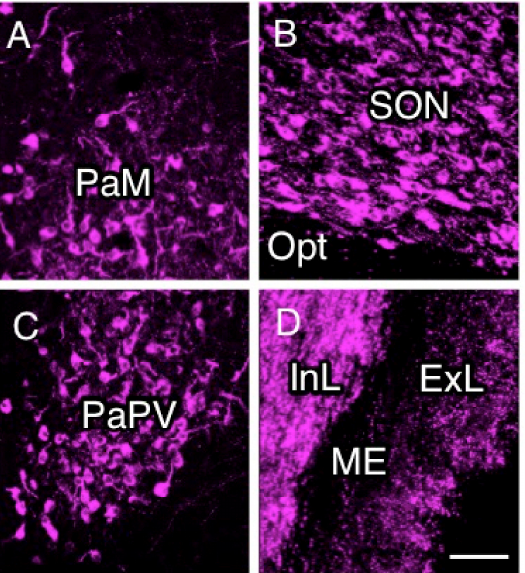
Figure 2. Immunofluorescence for vasopressin-associated neurophysin (NPII) in the macaque hy- pothalamus. NPII-immunoreactivity was observed in the paraventricular nucleus (PVN) of the hypothalamus; PaM, magnocellular part of the PVN ( A ); supraoptic nucleus ( B ); PaPV, parvocellular part of the PVN, ventral division ( C ); and median eminence (ME) ( D ). Opt, optic nerve; InL, internal layer of the ME; ExL, external layer of the ME. Scale bar, 100 µ